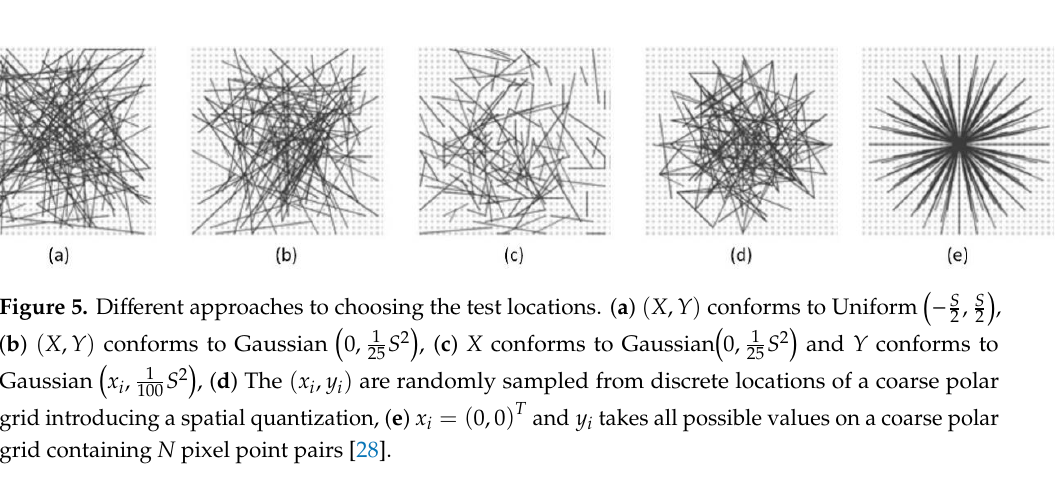
takes all possible values on a coarse 𝑖